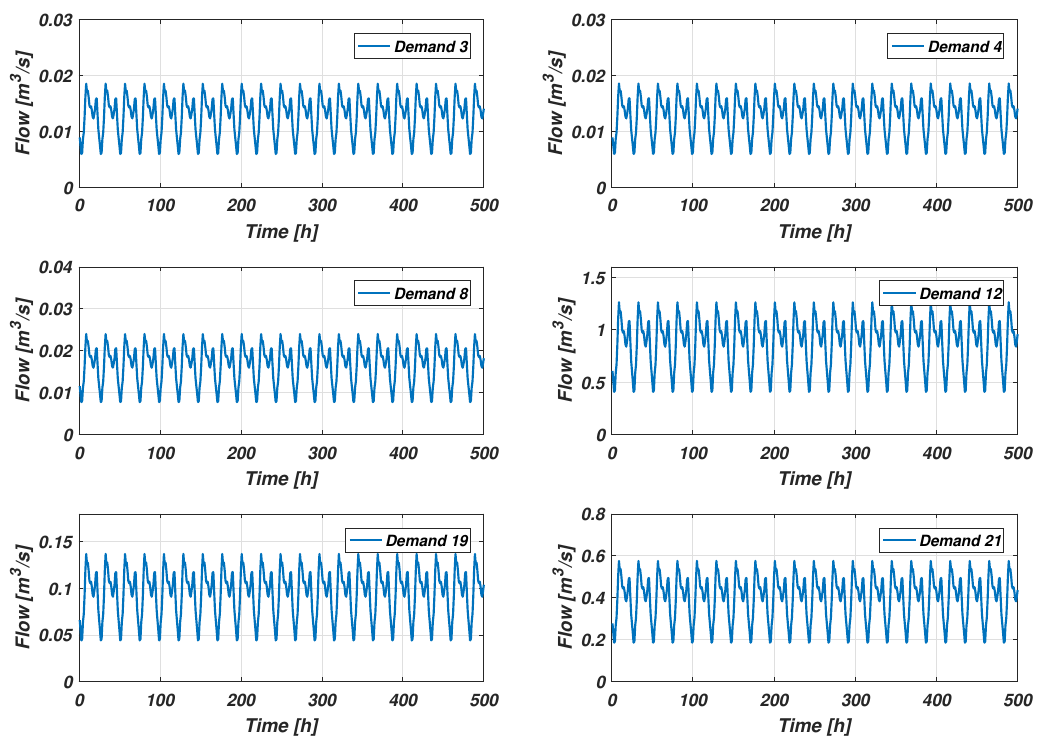
Figure 9. Drinking water demand for several